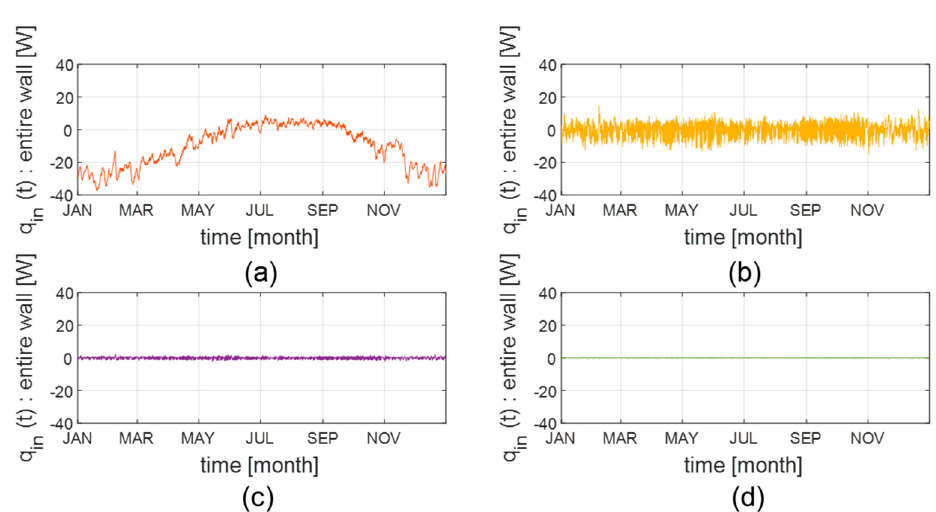
Figure 16. Residual of annual heat flow through the entire wall: ( a ) Model 1; ( b ) Model 2; ( c ) Model 3; ( d ) Model 4.